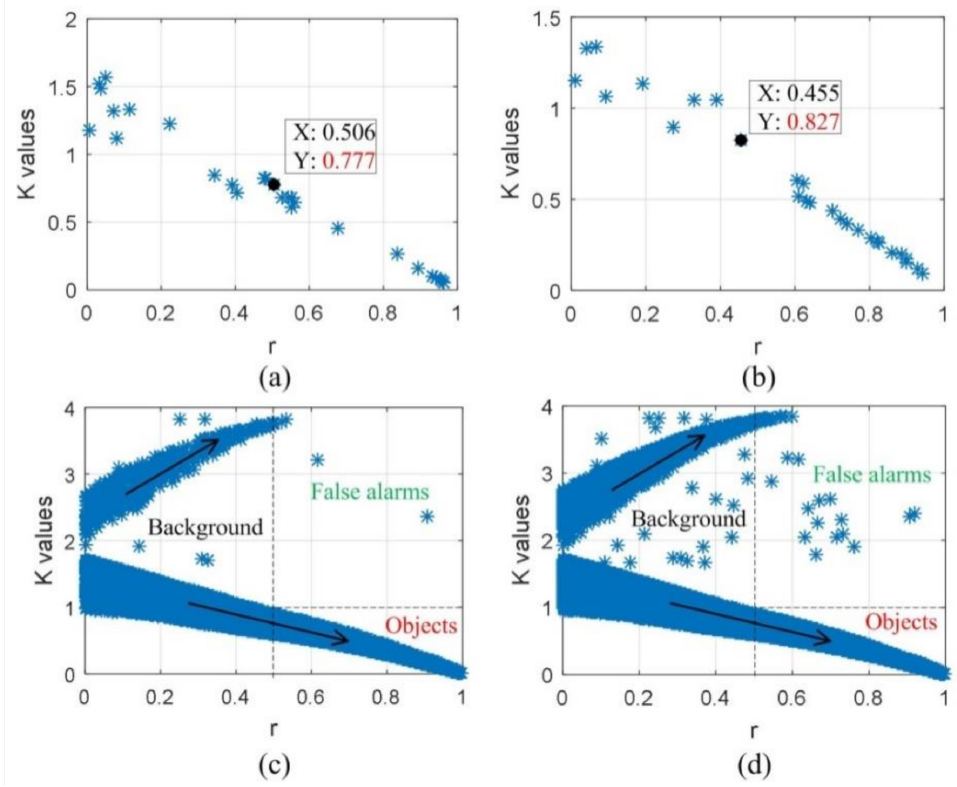
Figure 5. The relation between K values and correlation coefficients. ( a ) Ob 1. ( b ) Ob 2. ( c ) Pixel: 200 × 200. ( d ) Pixel: 400 ×